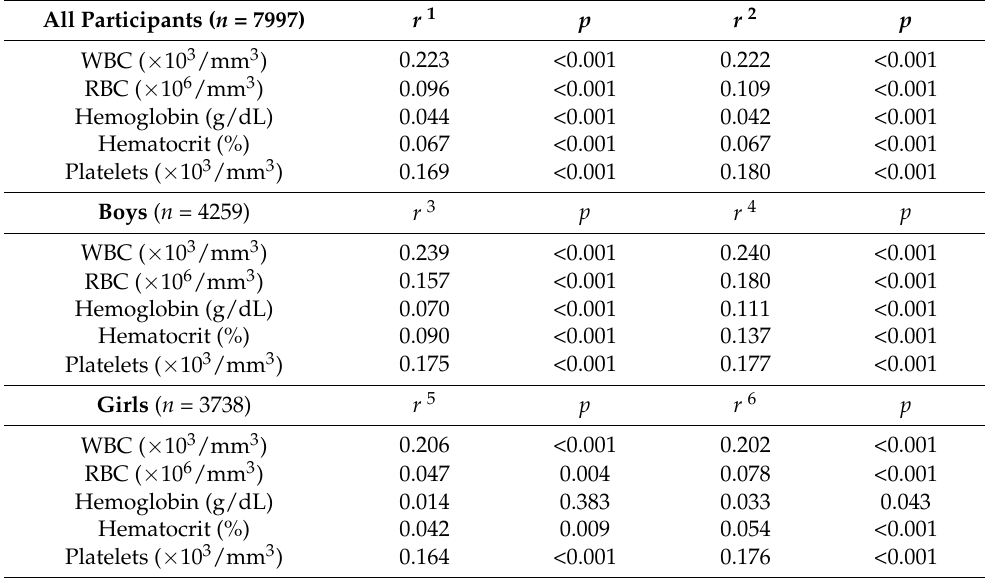
Table 4. Unadjusted and adjusted correlations between body mass index (BMI) standard devia- tion score (SDS) and white blood cell (WBC), red blood cell (RBC), hemoglobin, hematocrit, and platelet